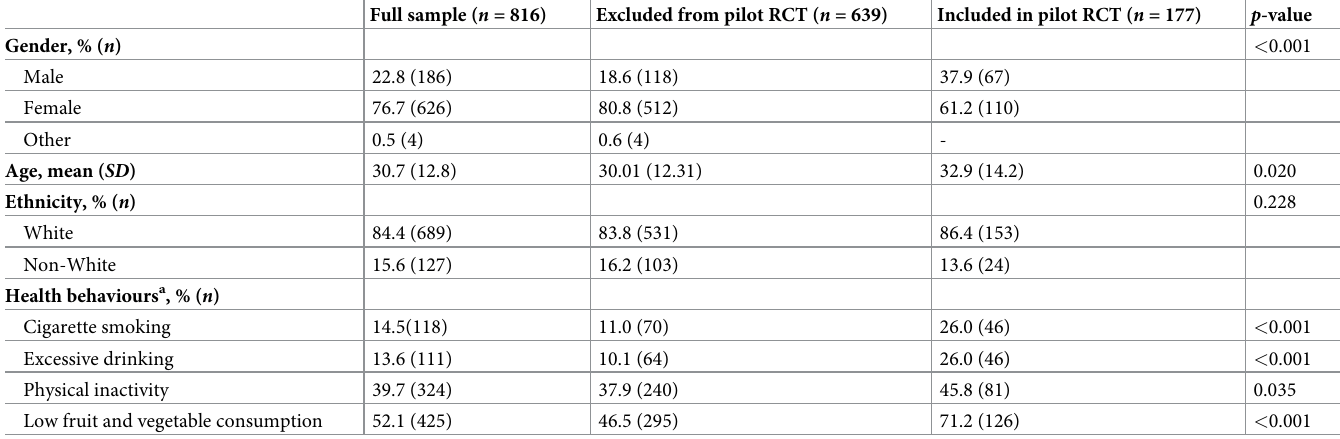
Table 2. Participant